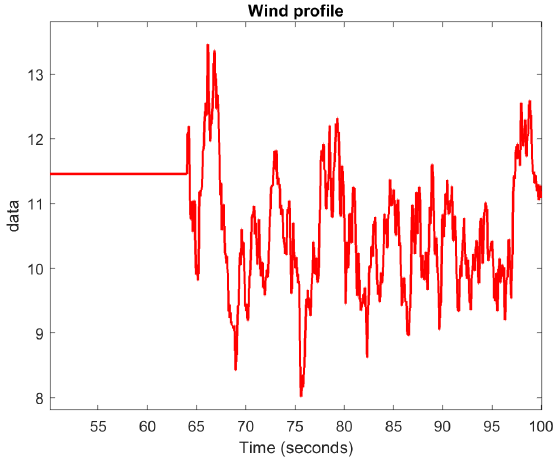
Figure 17. Real wind profile used in the simulations.